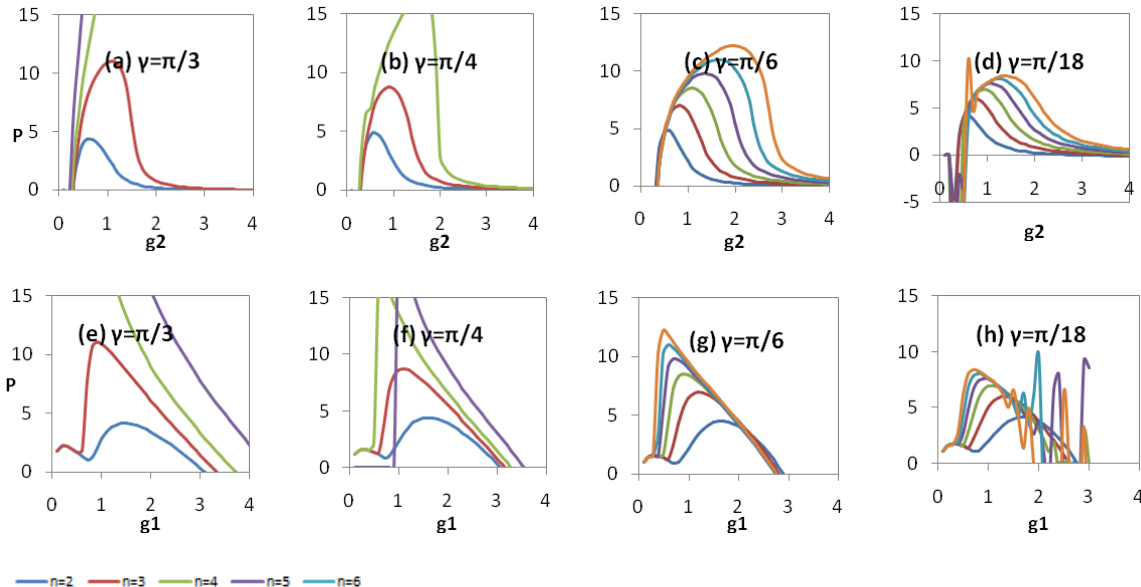
Figure 2: Effects of fiber orientation. One layer model with growth. Zero normal and shear stress boundary condition. µ =5kPa, k 1 =1, k 2 =0.2. A/B = 0.5. (a-d) Critical buckling pressure P plotted against circumferential growth rate g 2 for various buckling mode. (e-h) Critical buckling pressure P plotted against radial growth rate g 1 for various buckling